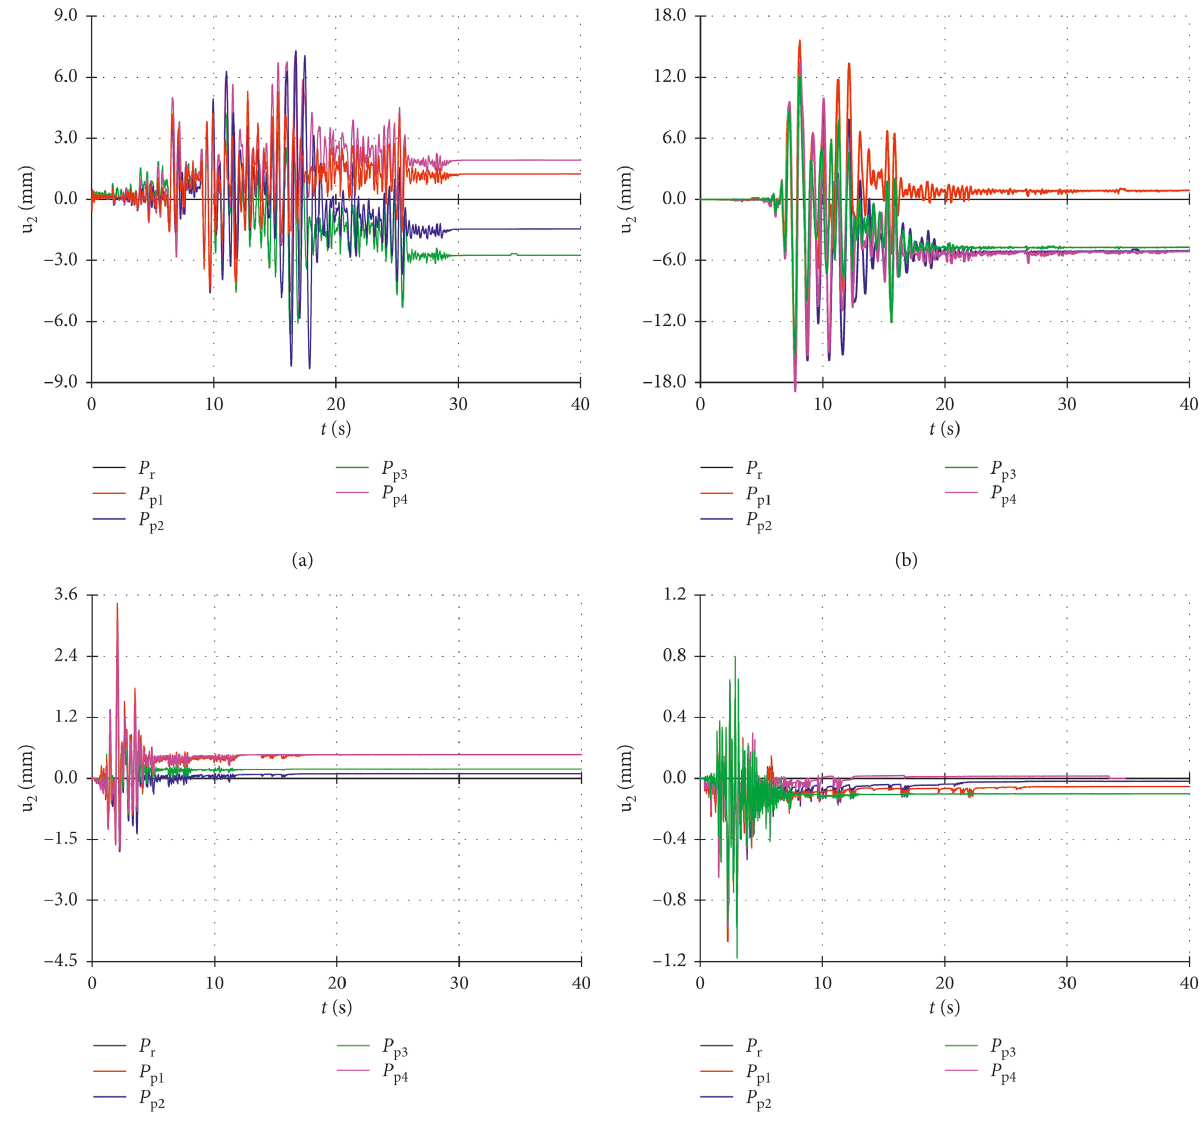
Figure 13: Horizontal displacement at the foundation top ( u (c) Accelerogram Ston (AS). (d) Accelerogram B. Luka